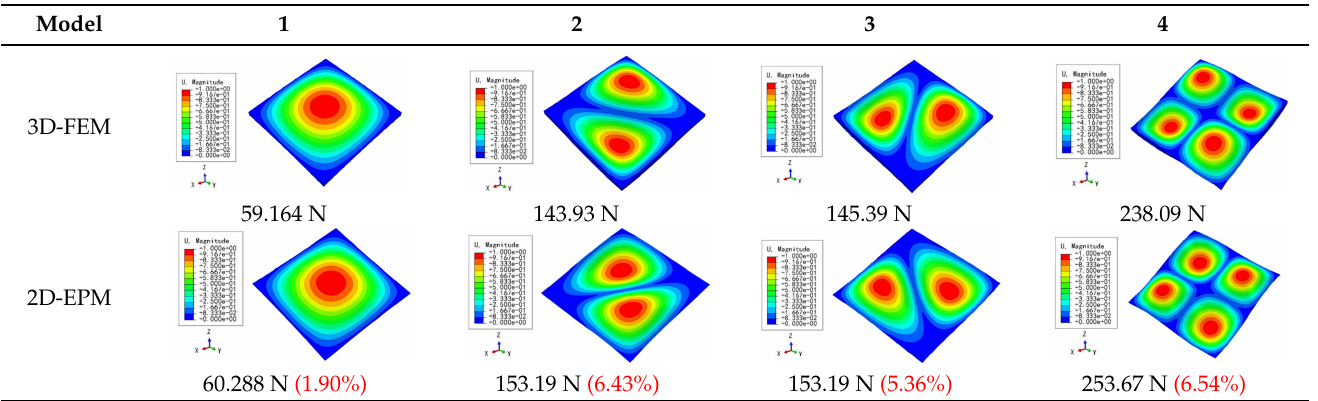
Table 11. Comparison of the buckling modes and buckling loads of the X-shaped HSP under SSSS boundary conditions predicted by different models.